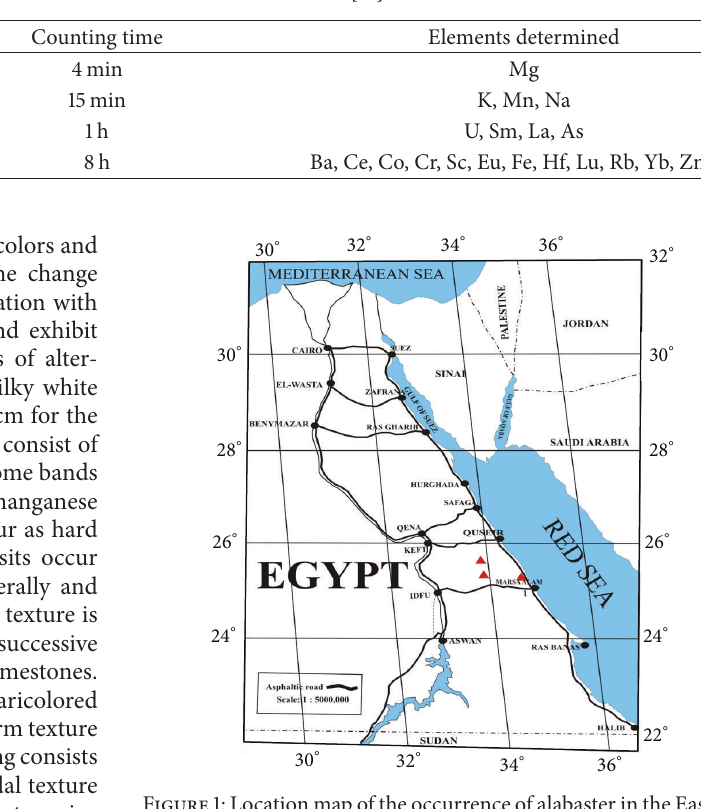
Figure 1: Location map of the occurrence of alabaster in the Eastern Desert, Egypt. The full points in the map indicate the sampling